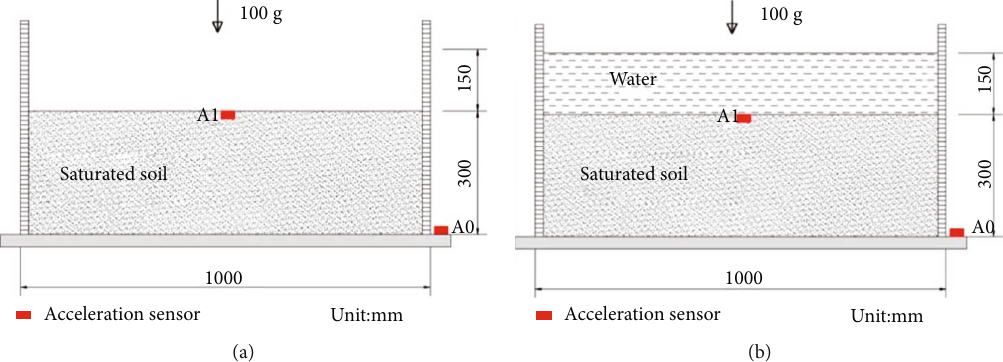
Figure 1: Design models of THE dynamic centrifuge shake table test: (a) Model 1 for the surface without water. (b) Model 2 for the surface with water. (units: mm).